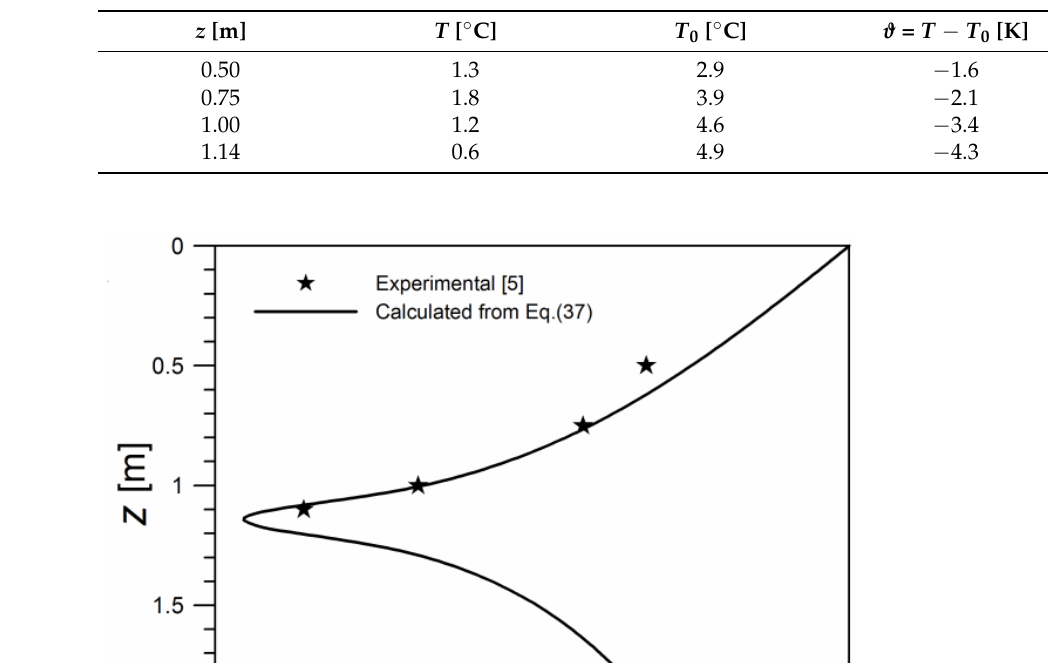
Table 3. The results of the experiments presented in [5], and the values ϑ used in Figure 11.